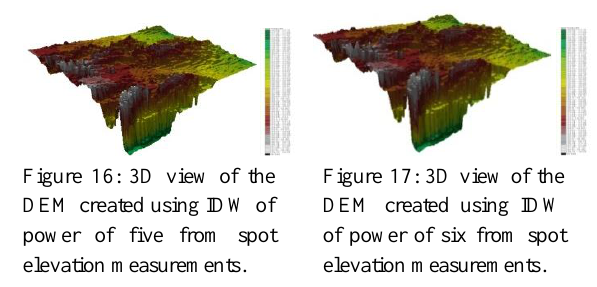
Figure 14: 3D view of the DEM created using IDW of power of three from spot elevation measurements.